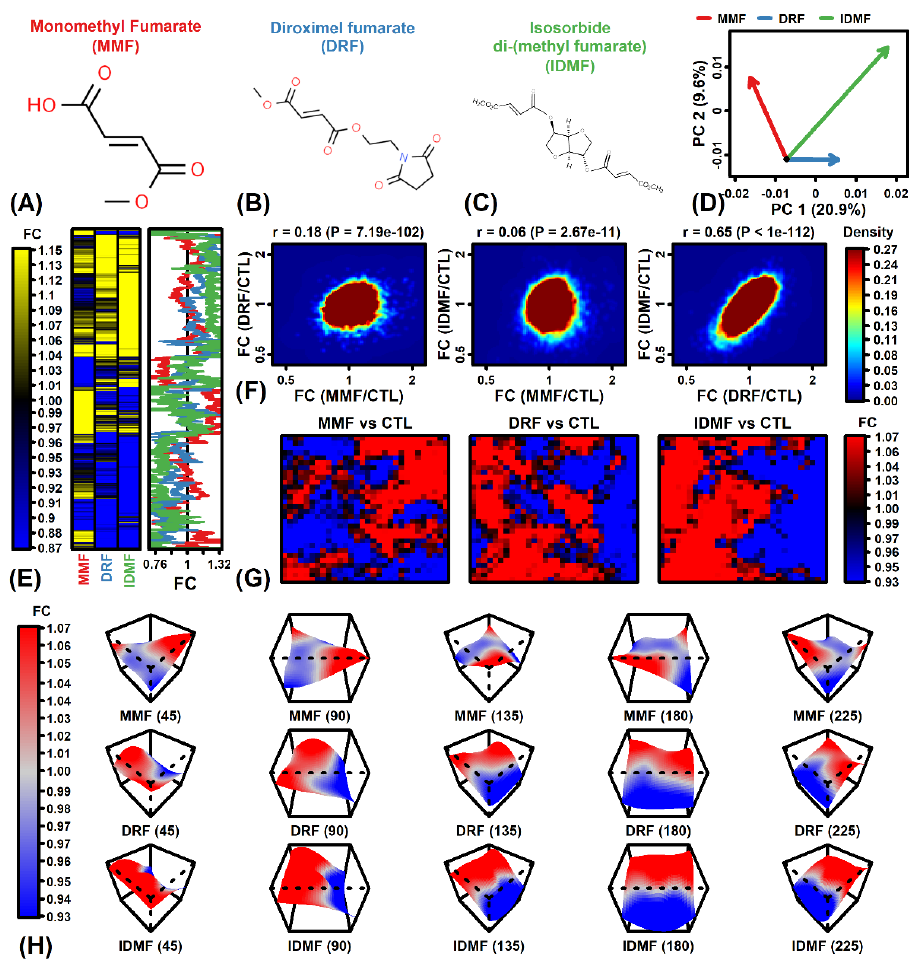
Figure 1. Differential expression comparison (MMF vs. DRF vs. IDMF). ( A – C ) Fumarate compound molecular structures. ( D ) PC differential expression vectors. Arrows start at the CTL treatment (bivariate mean) and terminate at the bivariate mean for each treatment (MMF, DRF, or IDMF). Longer arrows correspond to a stronger treatment effect. ( E ) Heatmap. FC change estimates are shown for the top-ranked 50% of genes ( n = 6493) having the largest absolute FC estimate (|FC|) among the three differential expression comparison. ( F ) Scatterplots. FC estimates are plotted to compare effects of MMF, DRF, and IDMF. The density of genes in each region is indicated (see color scale) and the Spearman correlation coefficient and p -value are shown (top margin). ( G ) Self-organizing maps